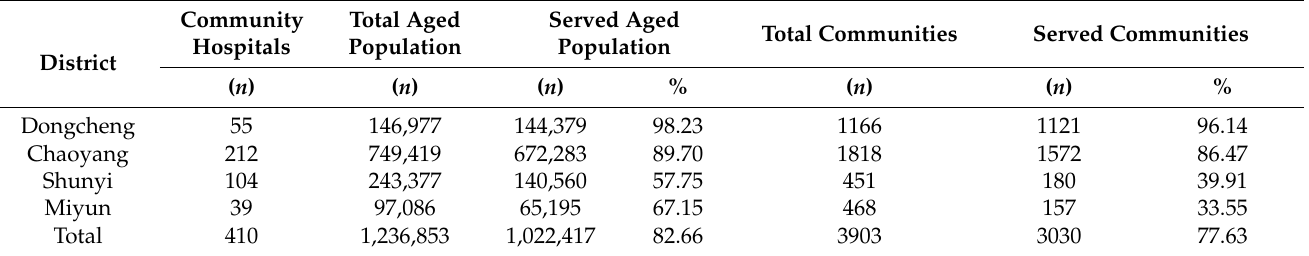
Table 2. The aged population and communities served by community hospitals within walking distance in four